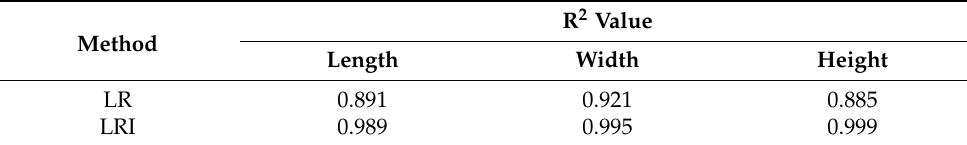
Table 6. R 2 results.